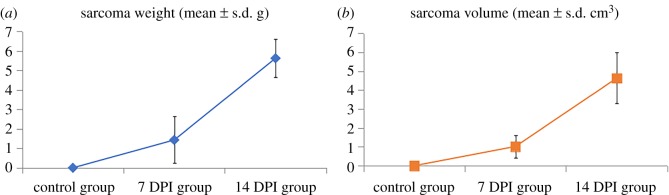
The sarcoma weights (a) and volumes (b) of the control, 7 DPI and 14 DPI group.